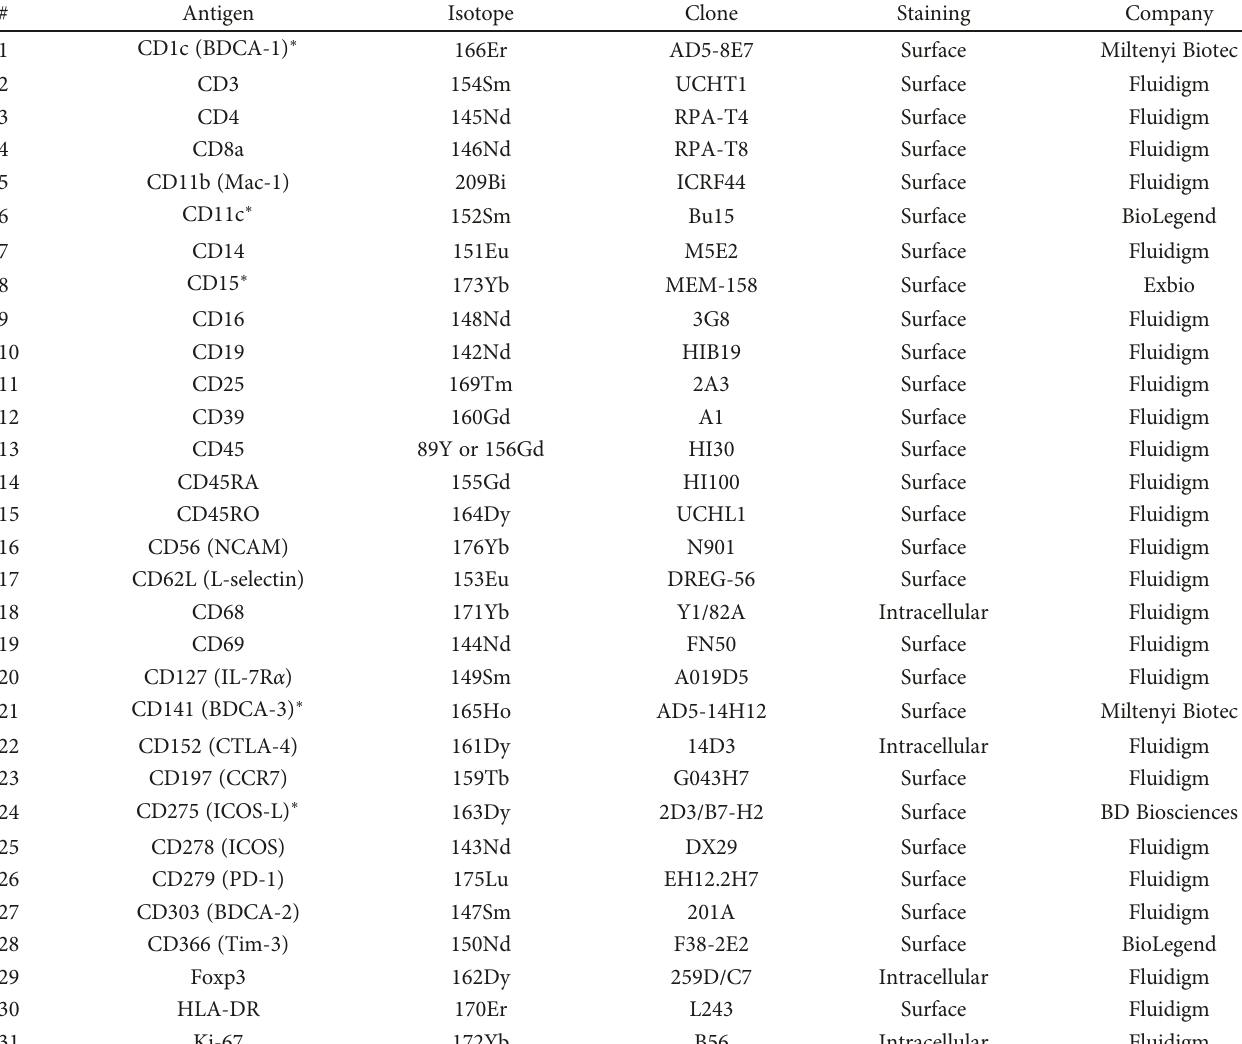
Table 1: Panel of antibodies for mass